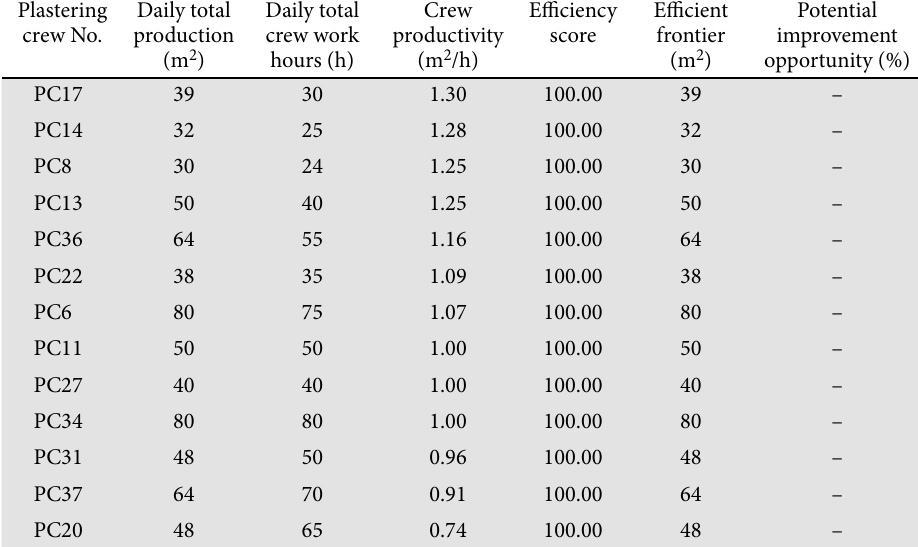
Table 3. Efficiency scores and ranking of plastering crew performance Plastering crew